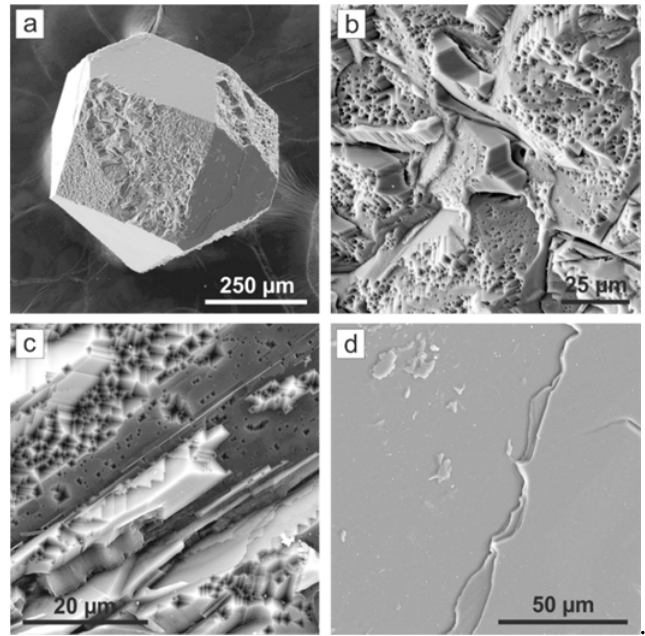
Figure 2. SEM micrographs of diamonds after run with Eu carbonate melt (run ES-6): ( a ) seed crystal with overgrown diamond layers; ( b , c ) fragments of {100} face; ( d ) growth layers on the (111)